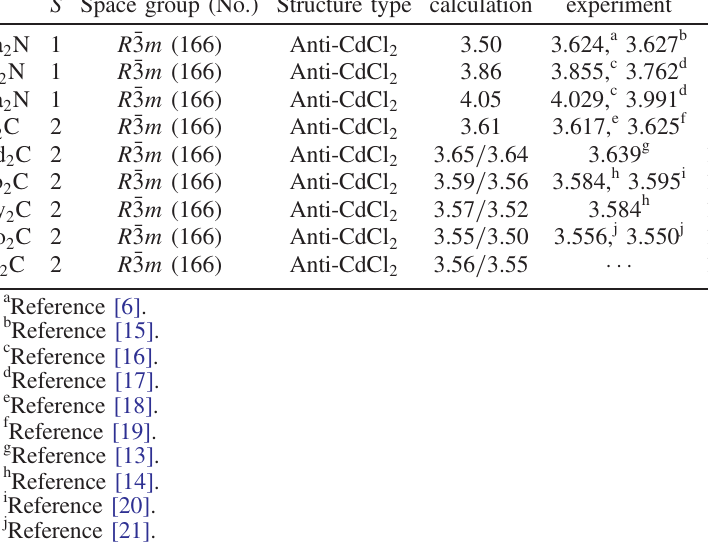
S Space group (No.) Structure type calculation